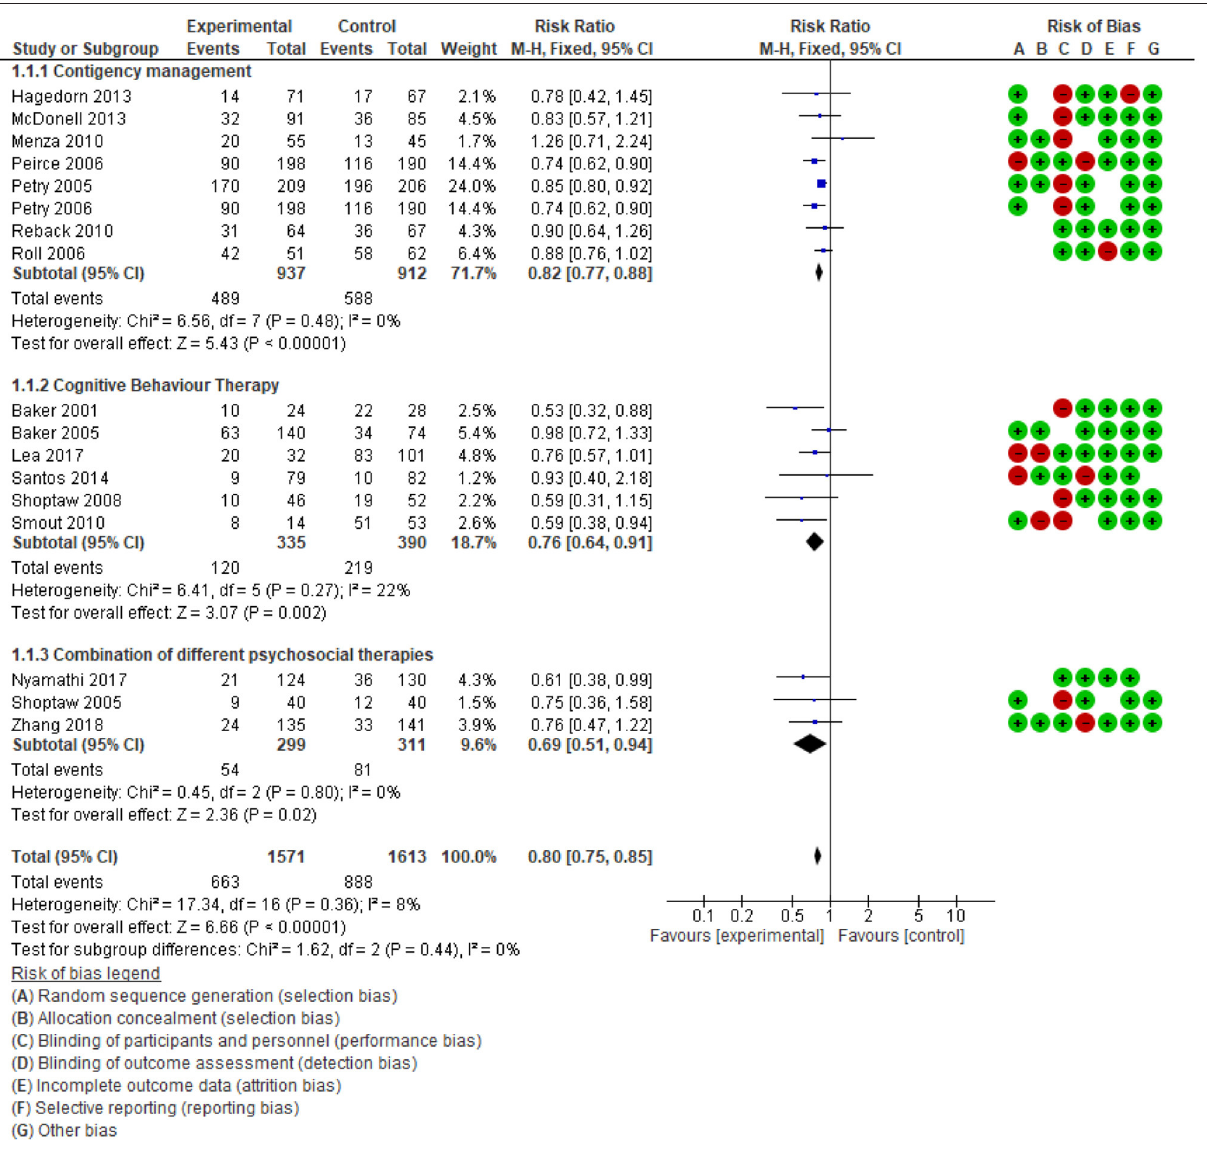
FIGURE 3 | Comparison % Drug use at the end of